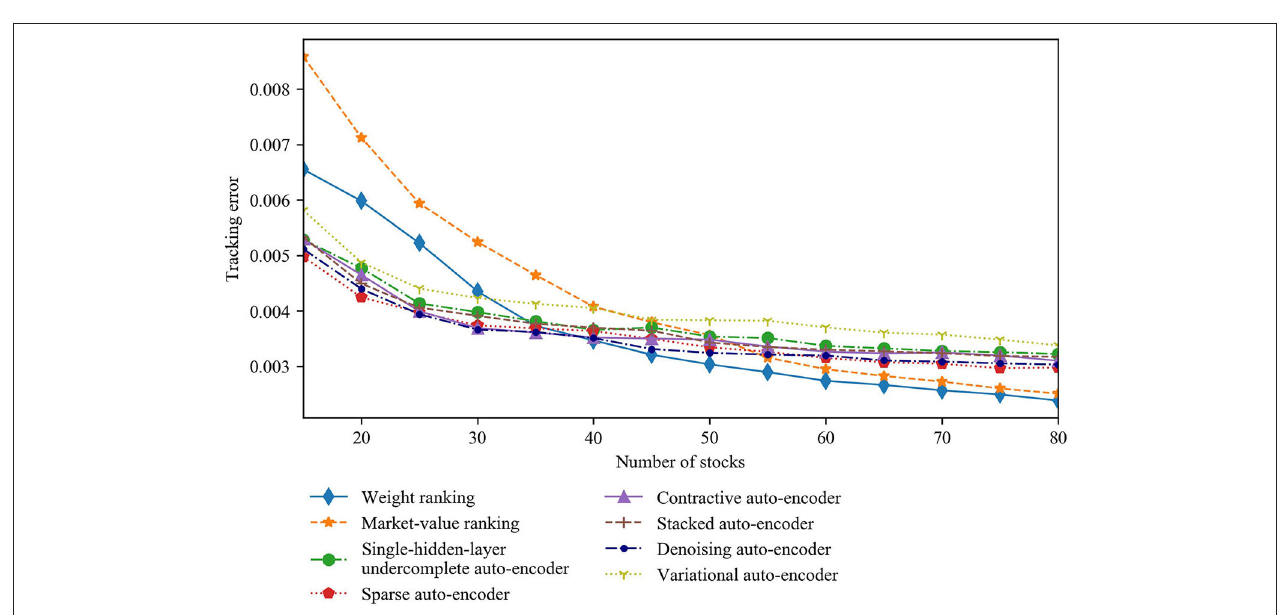
FIGURE 10 | Tracking error curves for all strategies covered by this